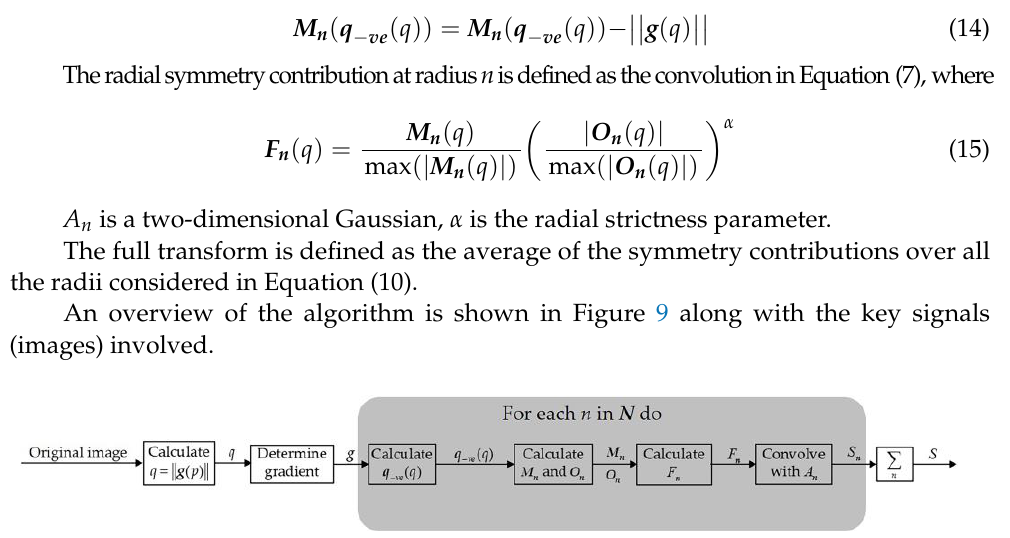
Figure 9. Schematic diagram of FGMRST.